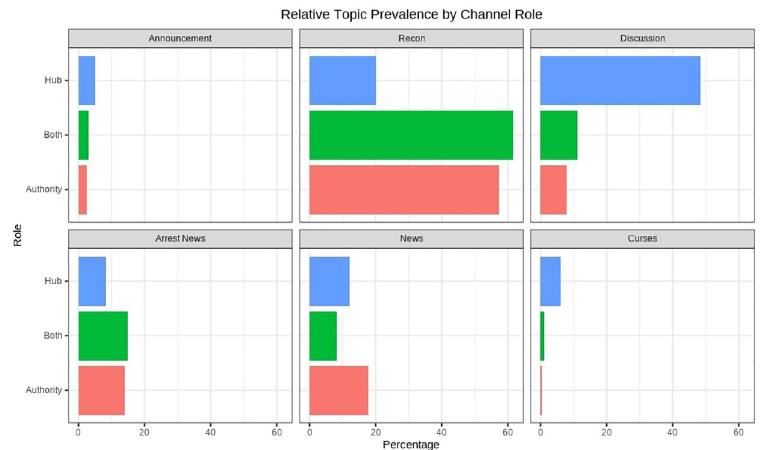
Fig 6. Relative topic prevalence by channel